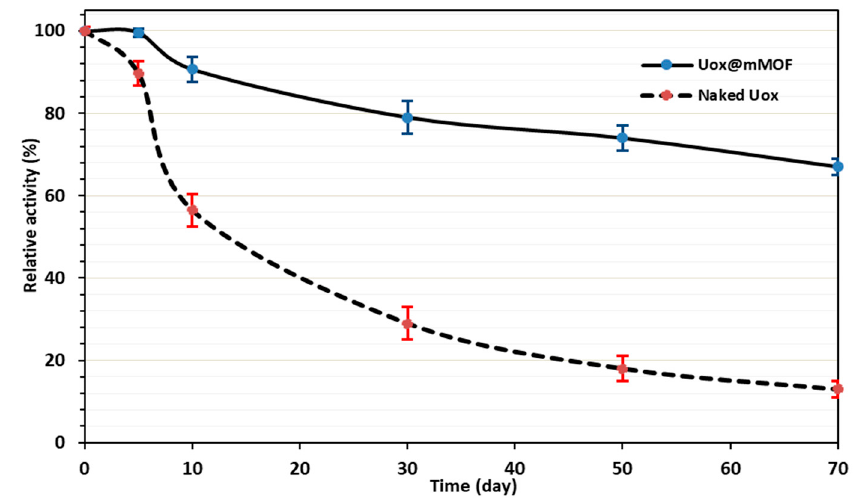
Figure 10. Storage stability